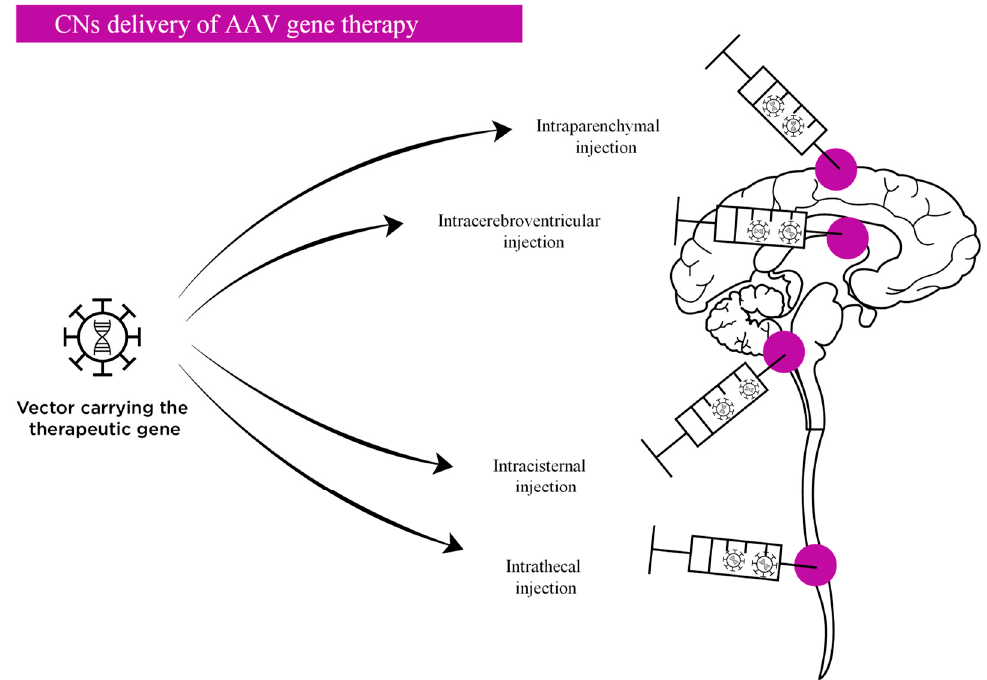
Figure 2. In vivo direct CNS administration routes for neuronopathic MPS. This approach includes intraparenchymal, intracerebroventricular (ICV), intracisternal (IC) and intrathecal (IT) administration. Direct CNS-targeting strategies generally represent highly invasive approaches for human therapeutic application.